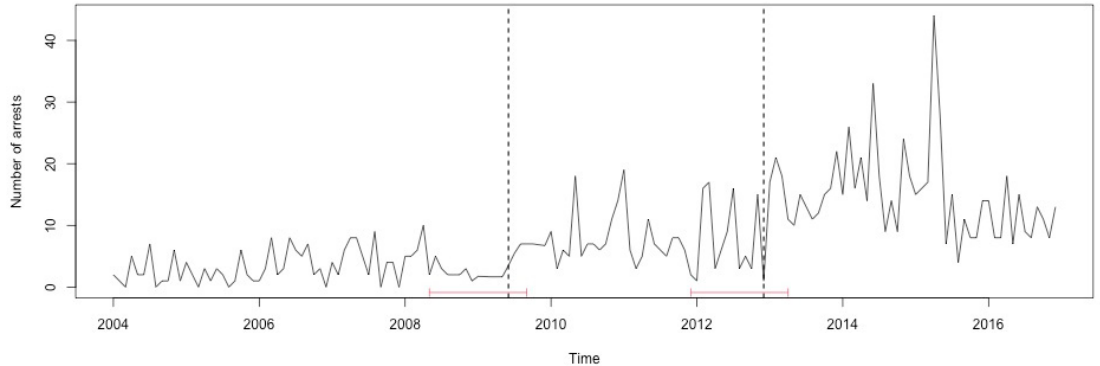
Figure A28. Methamphetamine foreign nationals arrests 2004–2016 in the Czech Republic and structural breaks.